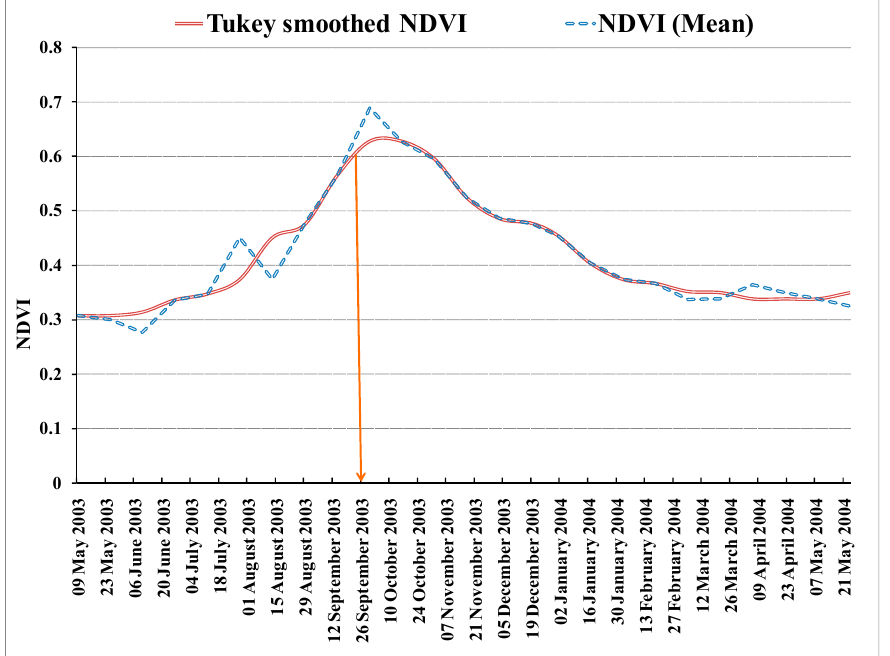
Figure 10. Raw MODIS NDVI and TS-smoothed reconstructed NDVI time series of year 2003–2004 for derivation of maximum of the season in Tectona grandis indicated by orange arrow.